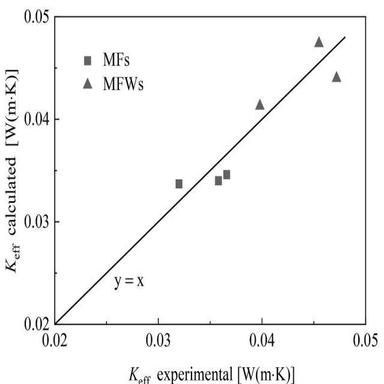
Comparison between experimental and model data.